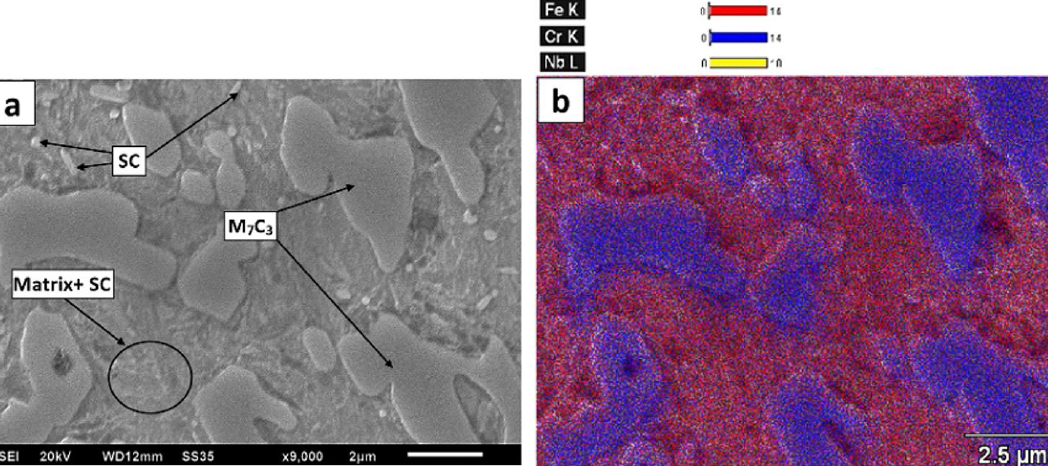
Figure 6a by the letter “a”, plate-like shapes, identified by the letter “b”, and in larger quantities, the rod-like particles, identified by the letter “c”. These morphologies were found by Powell and LAIRD (1992) 20 for secondary carbides of the M